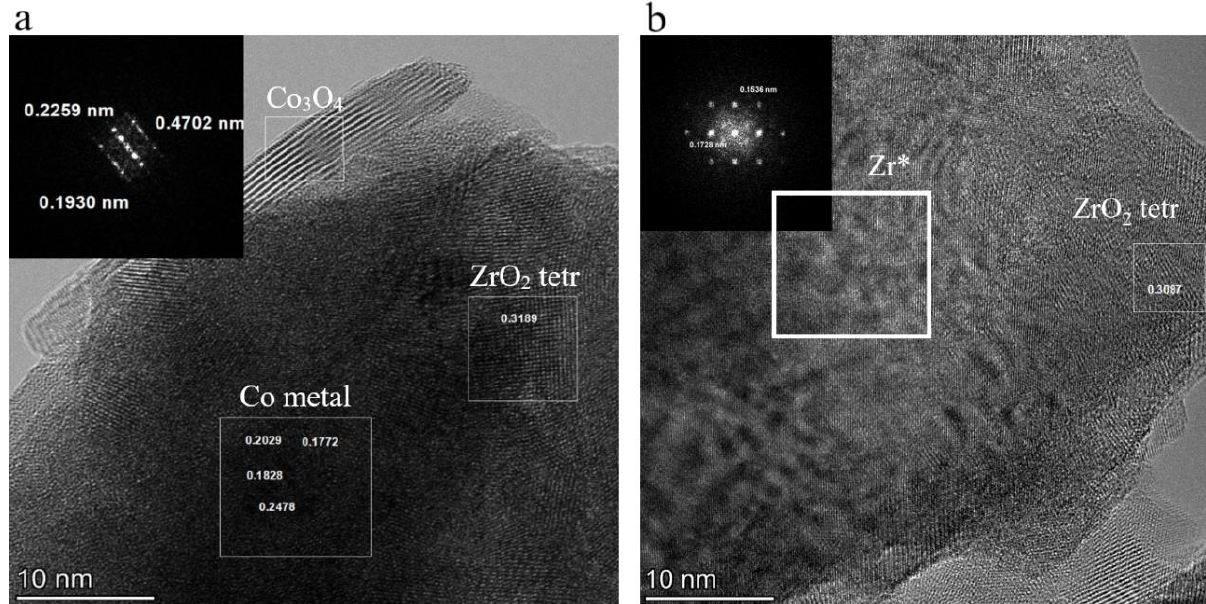
Figure 7. HRTEM images of: ( a ) typical Co-Zr mechanical alloying product particle with a metallic Co core. Top left insert-FFT image from Co 3 O 4 area; ( b ) typical Co-Zr mechanical alloying product particle with a metallic Zr core. Top left insert-FFT image from Zr * area with microstrains. The inhomogeneity of the MA Co-Zr product was also confirmed by the Raman spectroscopy data (Figure 8). The diameter of the laser beam used in the setup was approximately 2 µm, which allowed observing different parts of the sample. Different points in the sample demonstrated the prevalence of either zirconium oxide (143, 245, 301, 435 and 625 cm −1 bands corresponding to vibrational modes of cubic ZrO 2 [41]) or cobalt oxide with spinel structure and vibrational modes of 190, 470, 511, 606, and 674 cm −1 . All these bands correspond to F 2g , E g , F 2g , F 2g , A 1g Raman bands of Co 3 O 4 [42].